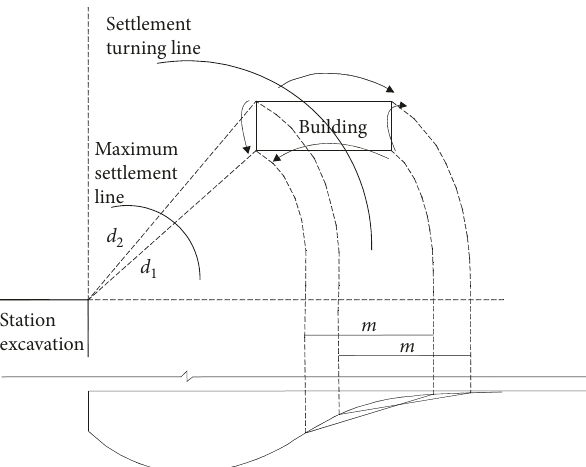
Figure 11: Torsional deformation of a building located outside the excavation